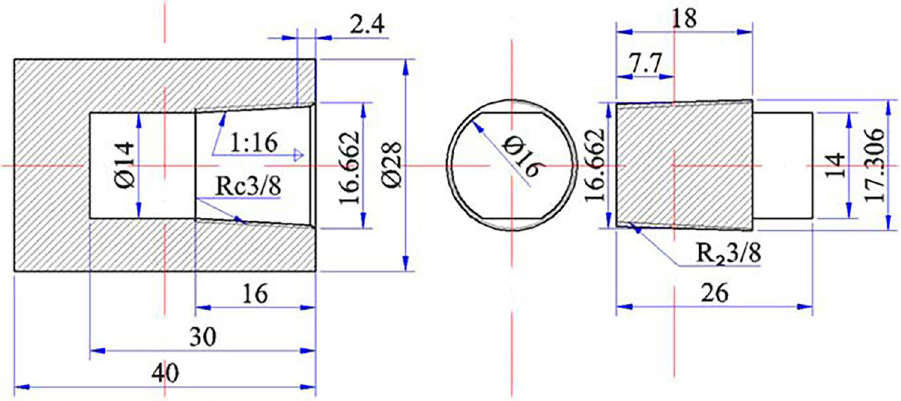
Figure 1. Schematic of the barrel-shaped cylinder and the screw plug.